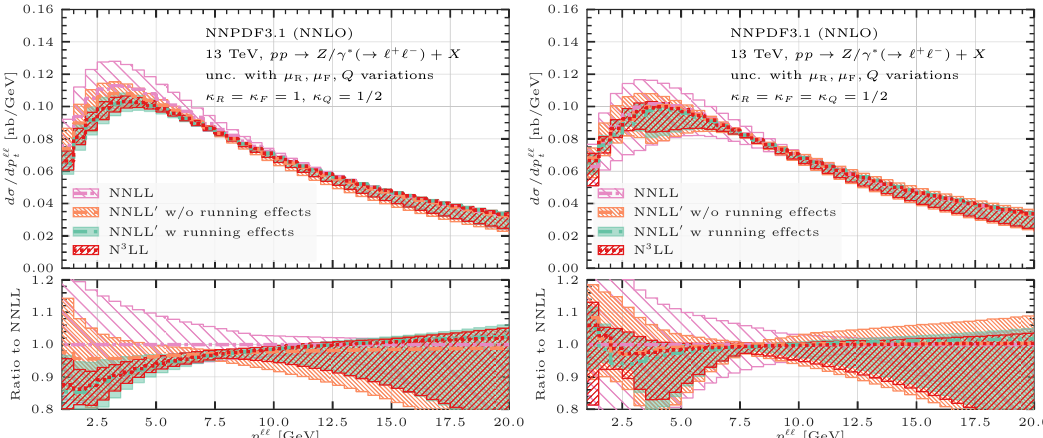
Figure 1 . Resummed p ‘‘ spectrum in the inclusive setup at NNLL, NNLL 0 , N 3 LL. Left panel: t central scales κ R = κ F = 1 , κ Q = 1 / 2 . Right panel: central scales κ R = κ F = κ Q = 1 / 2 .